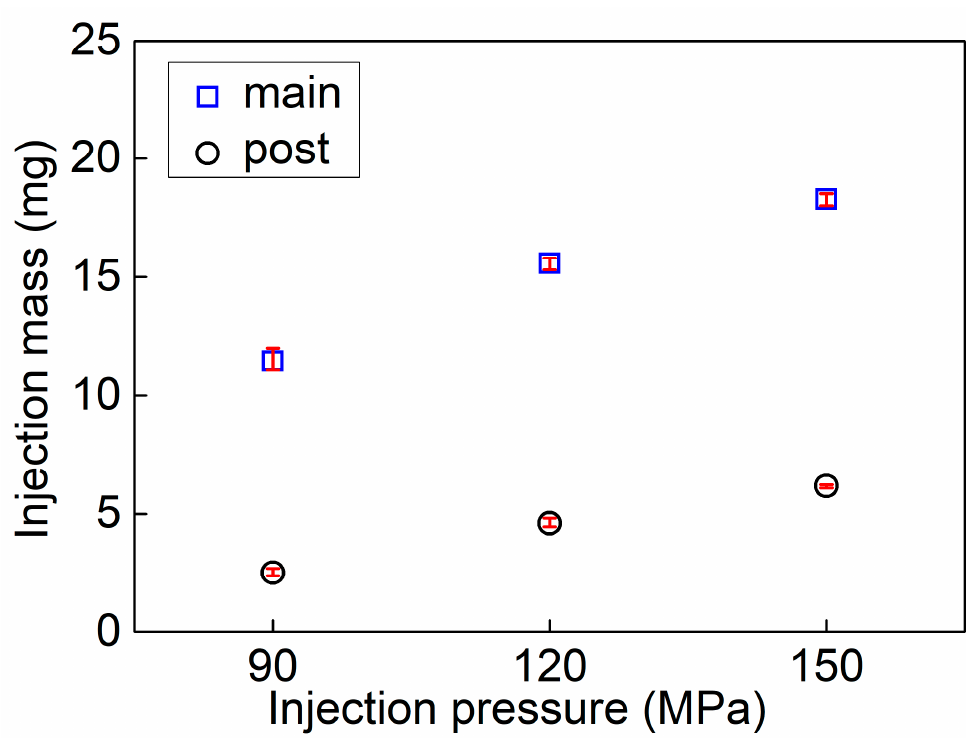
Figure 7. Results of each injection mass for the main-post strategy.